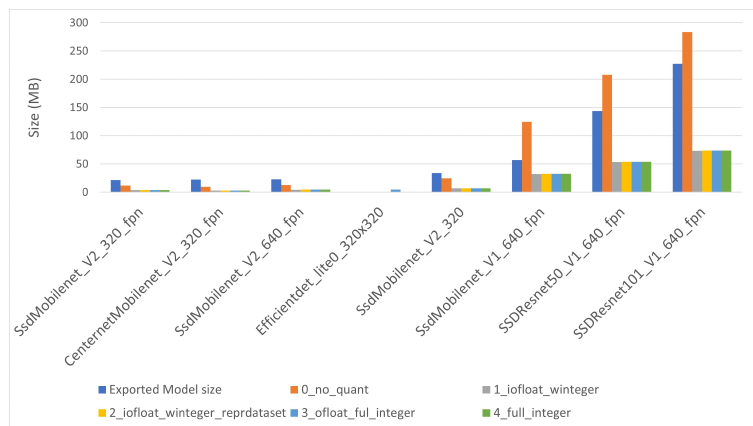
Figure 8. TensorFlow Lite converted file sizes for